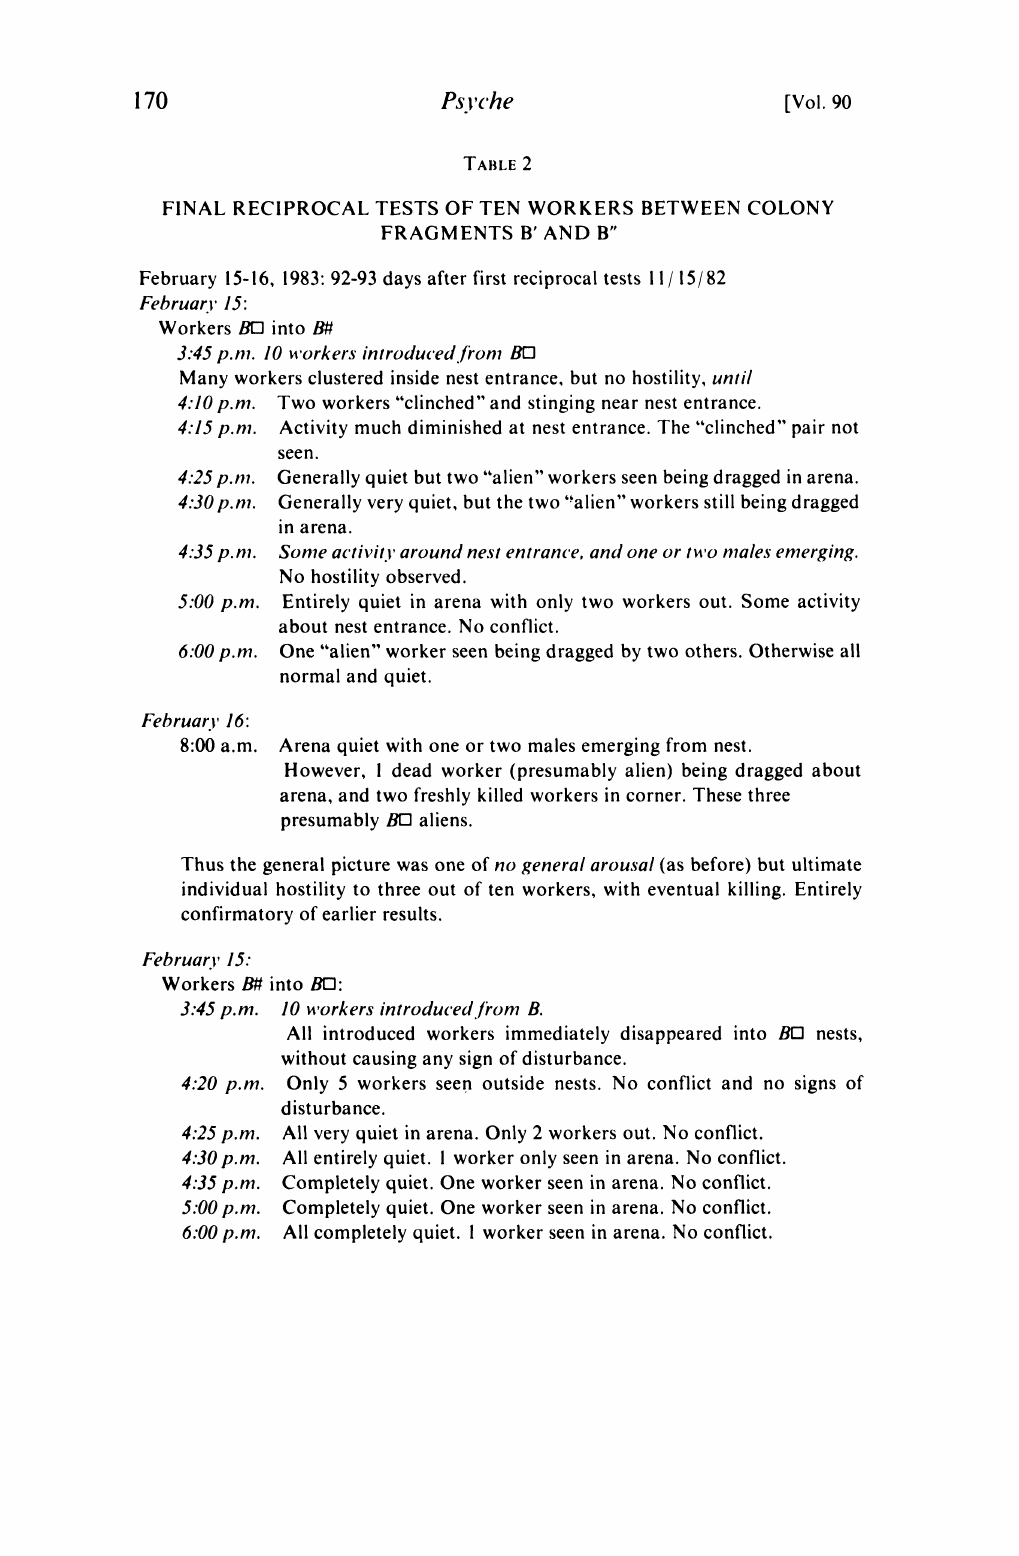
FINAL RECIPROCAL TESTS OF TEN WORKERS BETWEEN COLONY FRAGMENTS B’ AND B" February 15-16, 1983:92-93 days after first reciprocal tests 15/82 February 15: Workers BEi into